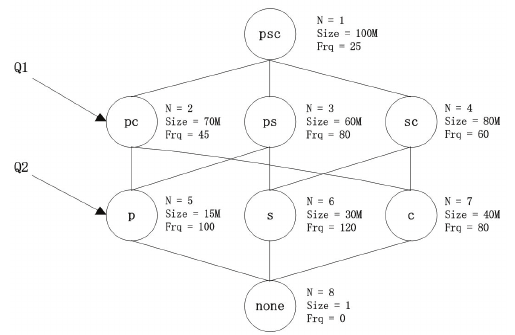
Fig. 1. A Multi-dimensional cube